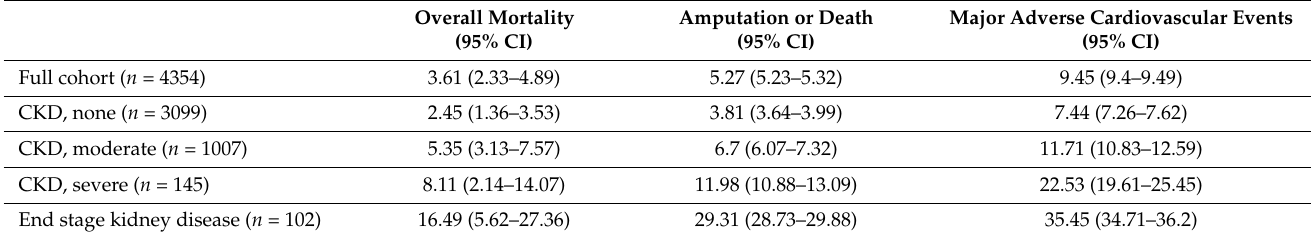
Table 2. 12-month incidence of overall mortality, amputation or death and major cardiovascular events for the full cohort and stratified by severity of CKD. Estimates were extracted from five imputed datasets with ten iterations each and combined using Rubin’s rules. CKD: Chronic kidney disease, CI: Confidence interval.